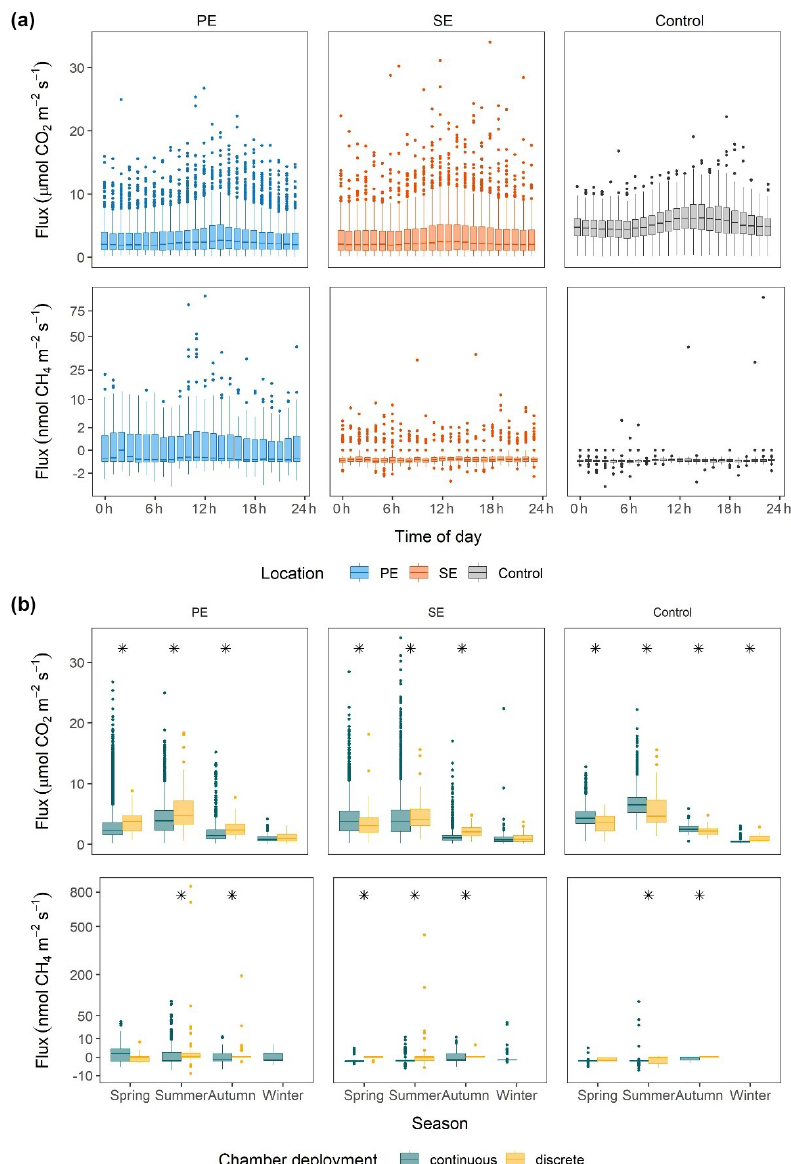
Figure 4. (a) Boxplots of diurnal patterns of observed fluxes over trenches receiving PE, trenches receiving SE and undisturbed soil as Control for CO 2 and CH 4 . (b) Boxplots comparing seasonal patterns of observed fluxes from continuous (blue) and discrete (red) measurements over trenches receiving PE, trenches receiving SE and undisturbed soil as Control for CO 2 and CH 4 . Groups marked with an asterisk had significantly different fluxes observed from both measurement approaches (Wilcoxon signed rank test). Note that in both subfigures the y scale for CO 2 is given in units different from units used for CH 4 and that the y axis for CH 4 has been square-root transformed to improve data